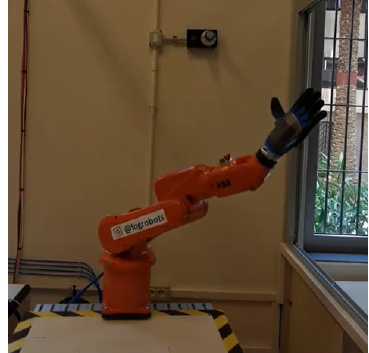
Figure 11. Snapshot of test